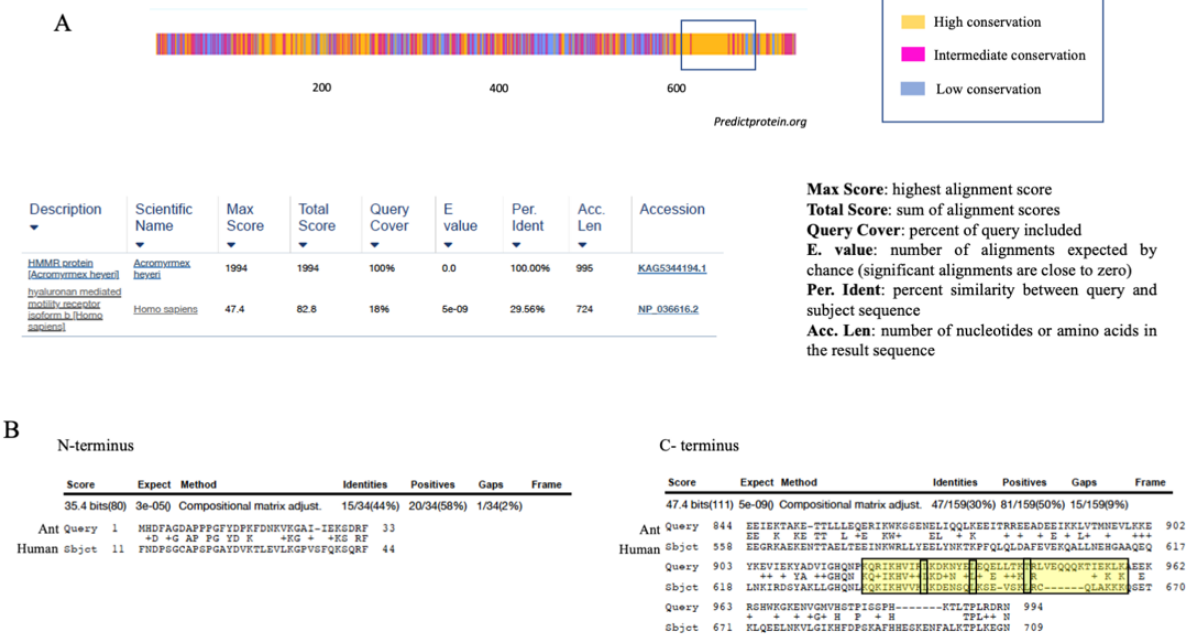
Figure 2. The predicted secondary structure of human RHAMM ( A ) and the known binding domains for which binding partners have been experimentally verified. ( A ) The secondary structure of RHAMM is predicted to be mostly helical (predictprotein.org (accessed: 18 September 2021)) and ( B ) the major binding domains identified to date occur in the alpha-